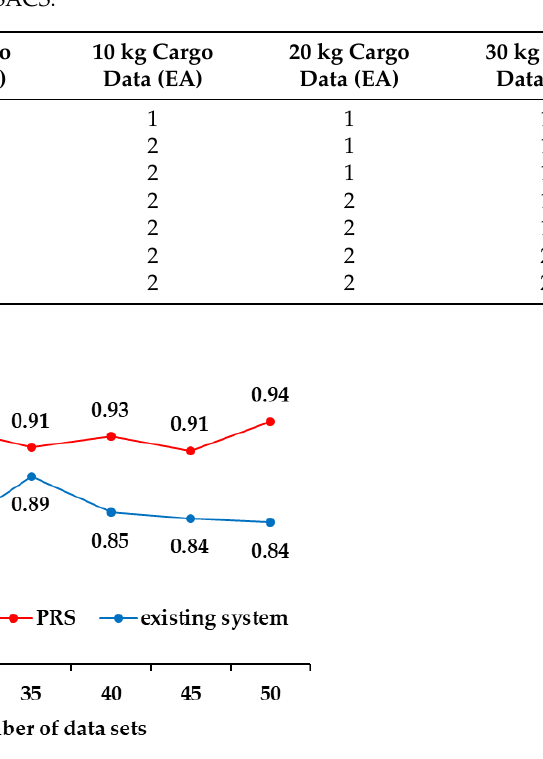
Table 7. The input data set of the SACS.